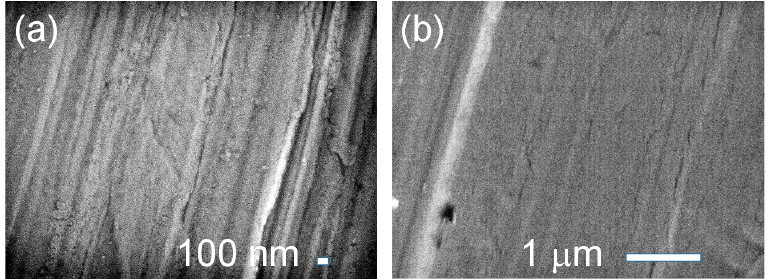
Figure 1. SEM images of 10-nm thick alumina ( a ) and 10-nm thick hafnia ( b ) on bare 25 micron thick Cu foil illustrating a fairly uniform coverage of the oxide on the copper.